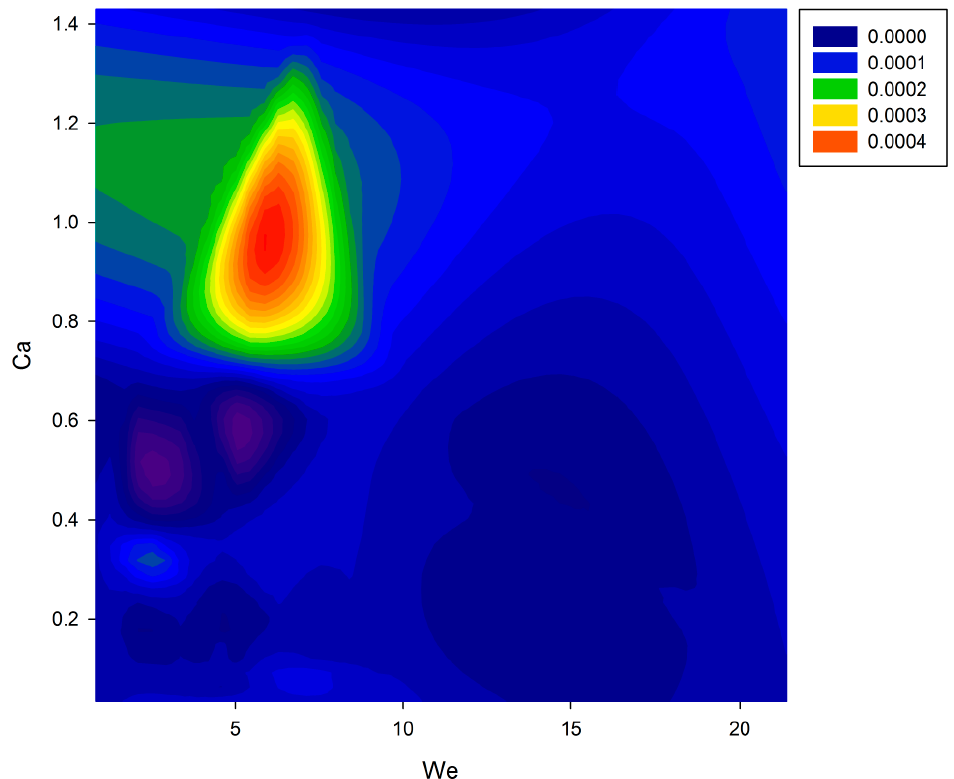
Figure 11. Break-up time as a function of the We–Ca space (obtained from the 25 runs).